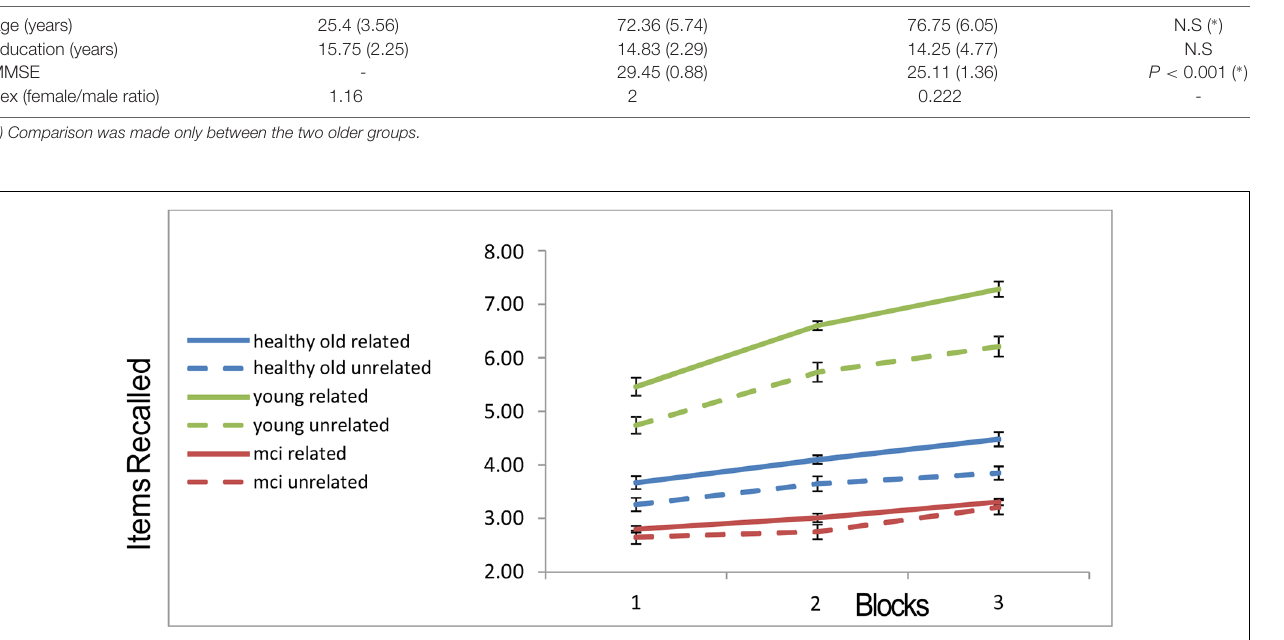
FIGURE 2 | Recall rates of the three groups across blocks. “Error-bars” correspond to within-participants standard-errors.